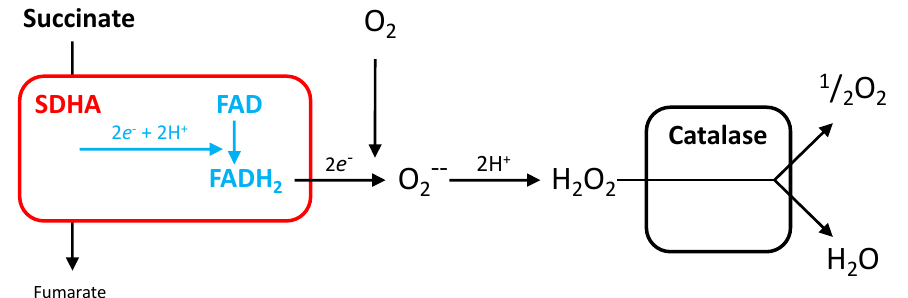
Figure 10. Hypothesis about autonomous SDHA activity. Breaking the link between SDHA and the rest of the SDH subunits would be the result of a loss of SDHB expression. Leakage of electrons from the SDHA FAD/FMN coenzyme would reduce oxygen with the formation of hydrogen peroxide. Catalase activity results in water as the final product for the transfer of two electrons, but with no intervention of MRC. While catalase would prevent H 2 O 2 accumulation, a sustained elevation in H 2 O 2 levels is expected.